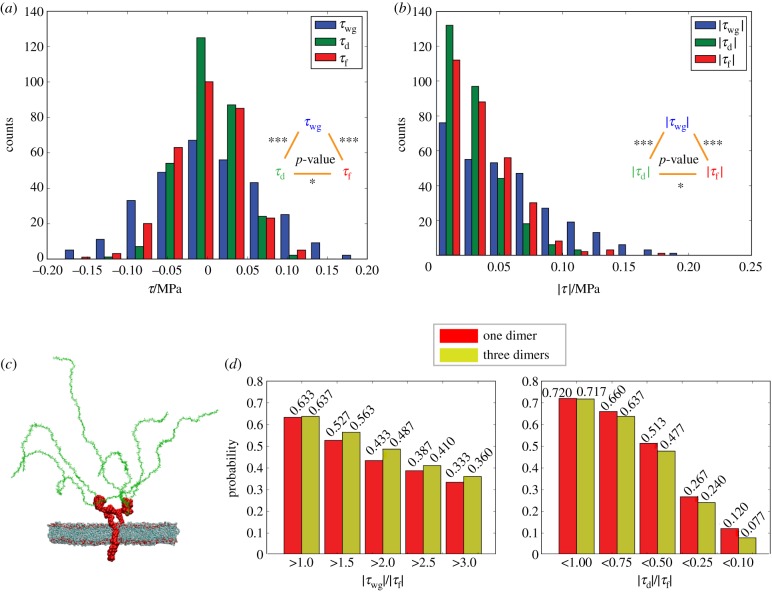
Shear stress distributions in the three sub-regions. (a) Shear stress distributions with the p-values of K–S tests for each of two distributions. (b) Distributions of shear stress magnitudes with the p-values of K–S tests for each of two distributions. (c) Configuration of the one-dimer in silico experimental system as the control group. Water and ions are not shown. (d) Comparisons of probabilities to obtain strong shear stress in the near-wall region and to obtain weak shear stress in the dendritic region between the three-dimer and the one-dimer cases. Statistical significance is given by *p < 0.05; **p < 0.01; ***p < 0.001; values are listed in the electronic supplementary material, table S3.